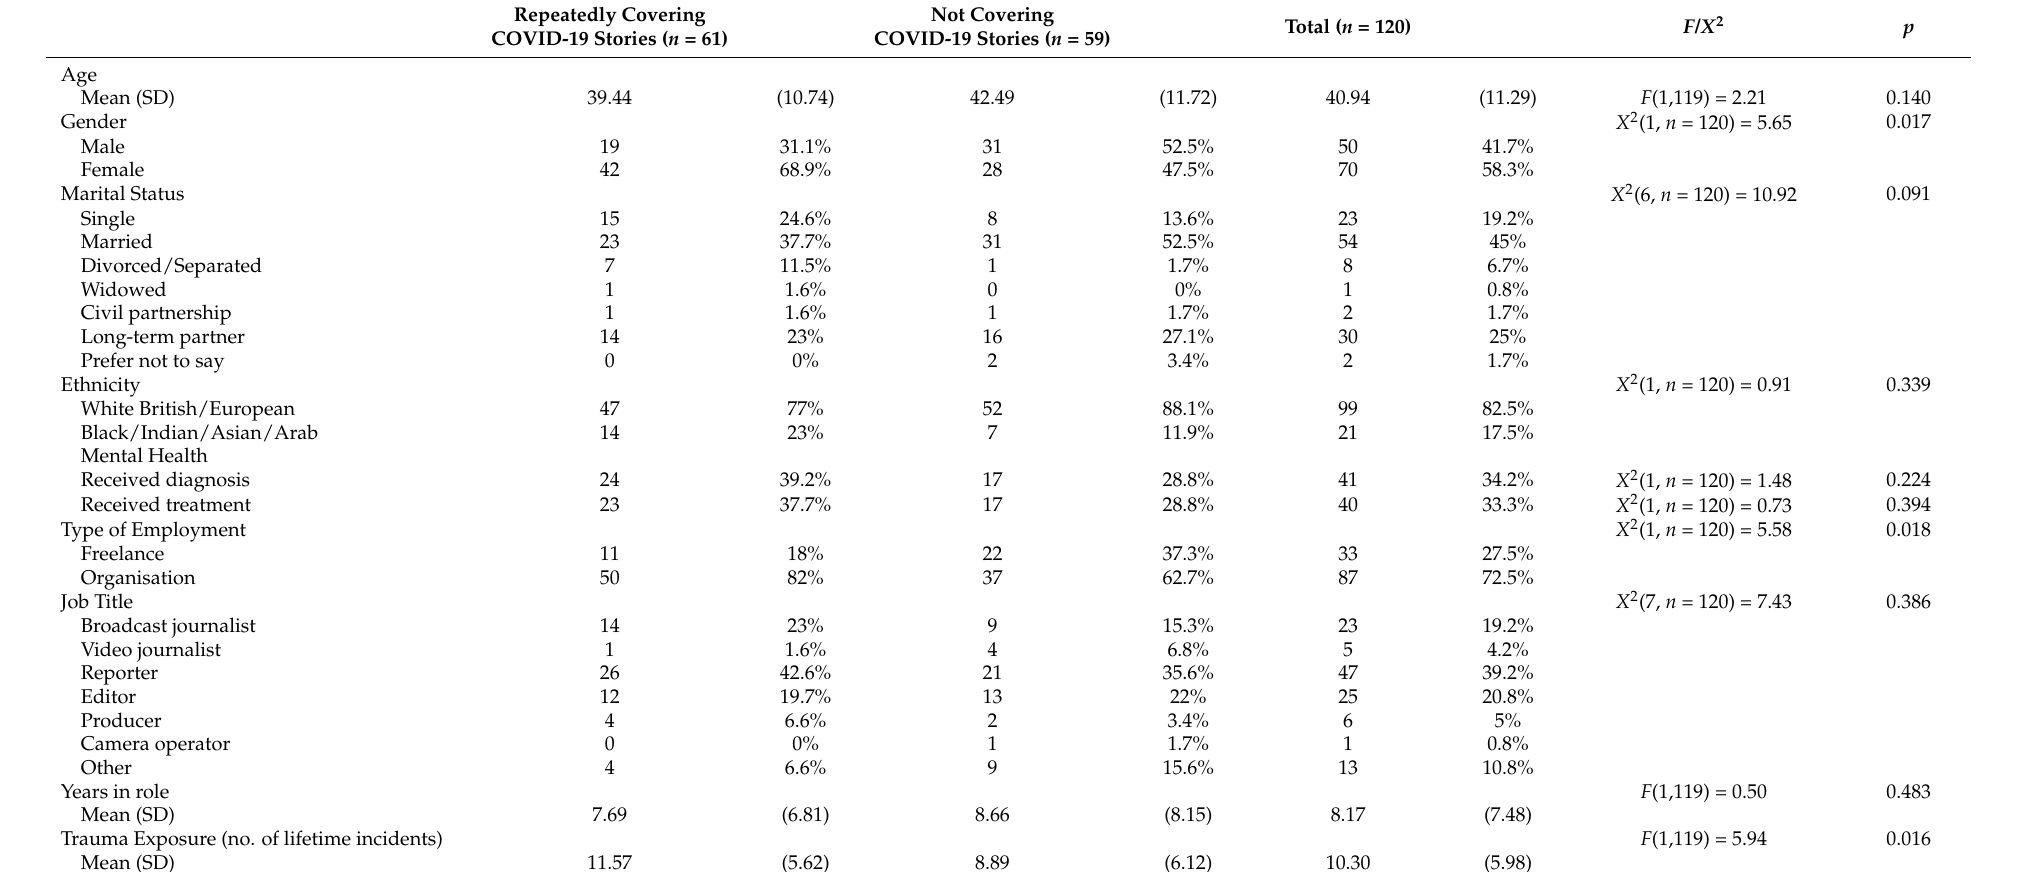
Table 1. Demographic characteristics of participants and symptom measure